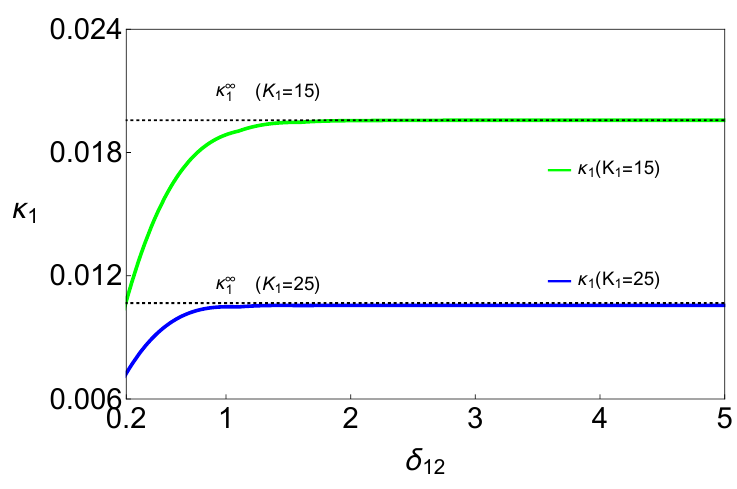
Figure 2 . E(cid:14)ciency factor with (cid:14) 12 for two di(cid:11)erent values of K 1 with a (cid:12)xed value of K 2 =